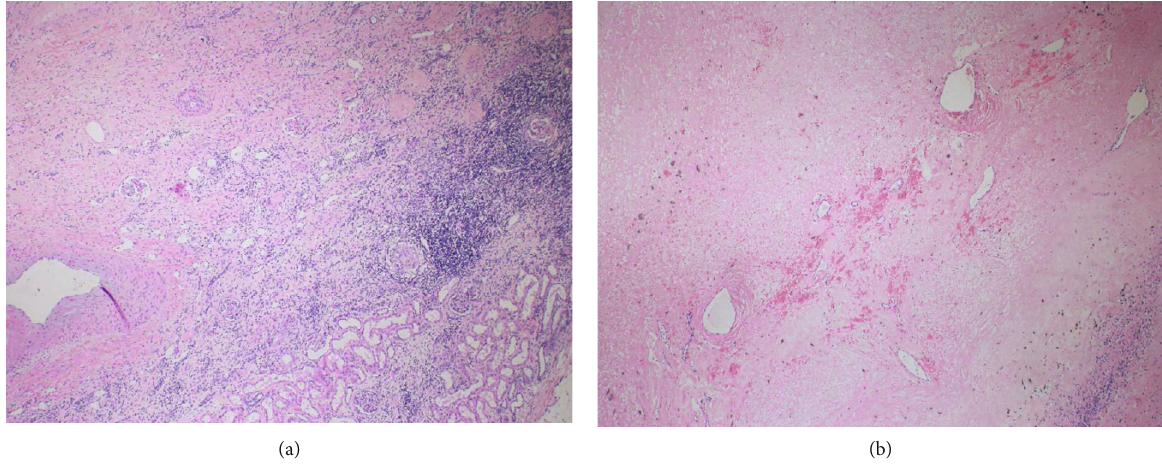
Figure 4: Final pathologic analyses of resected tumor specimen. (a) Resected tumor showing treatment e ff ect (4x magni fi cation). Large parts of the lesion are replaced by fi brosis with in fi ltrating lymphocytes. The relationship to normal viable kidney parenchyma is shown in the bottom right corner. (b) Resected tumor (4x magni fi cation) demonstrating that the center of the lesion is entirely necrotic. No viable tumor cells